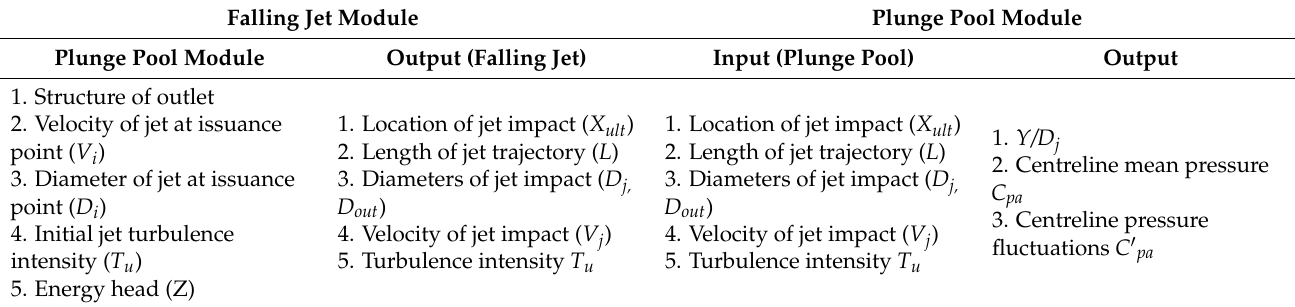
Table 8. Input and output parameters of the falling jet and plunge pool modules